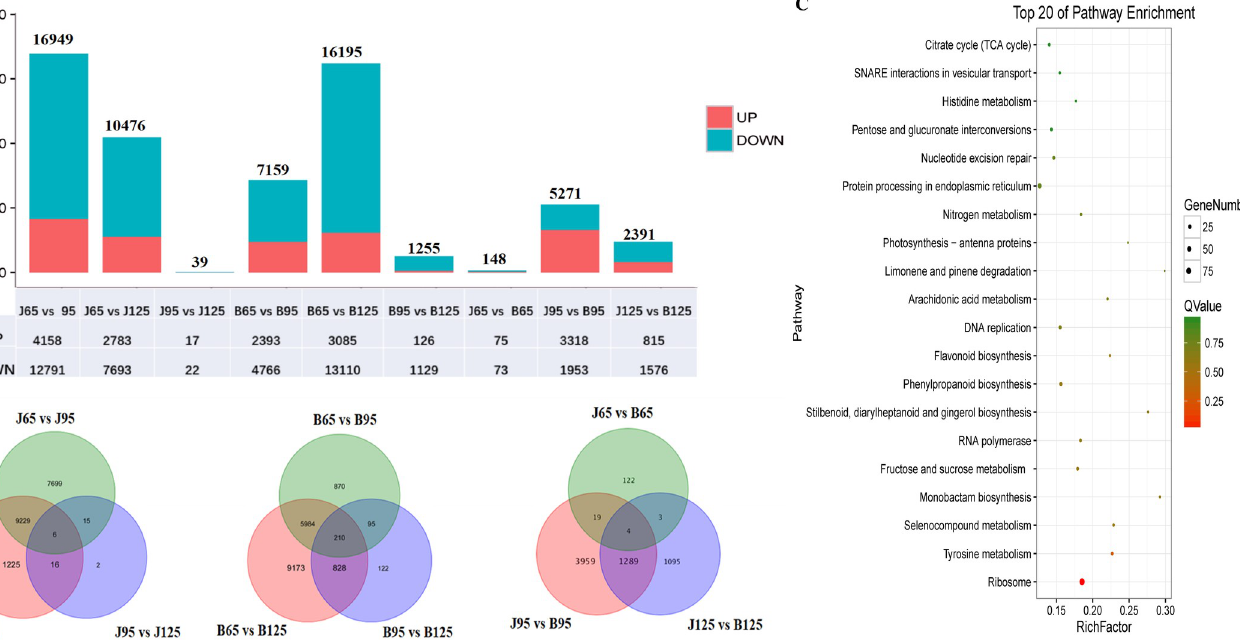
(Fig 4B). The expression of ALMT 9 and cyNADP-ME2 was 2-fold lower in BL than in JFZ at 125 DAF (Fig 4B). The expression of VHP1 observed in BL was 1.5-fold that of JFZ at 125 DAF (Fig 4B). Our transcriptome studies identified six DEGs related to fructose and sucrose metabolism (Fig 5A). NAD-SDH transcripts increased with fruit development and were 2-fold higher in BL compared with JFZ at 125 DAF (Fig 5B). The expression level of FRK1 showed the opposite trend and was significantly higher in JFZ compared with BL at 125 DAF (Fig 5B). SPS1 was